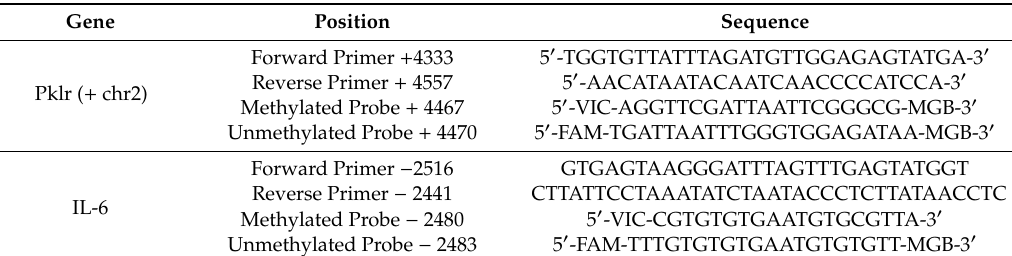
Table 1. QAMA Primers and